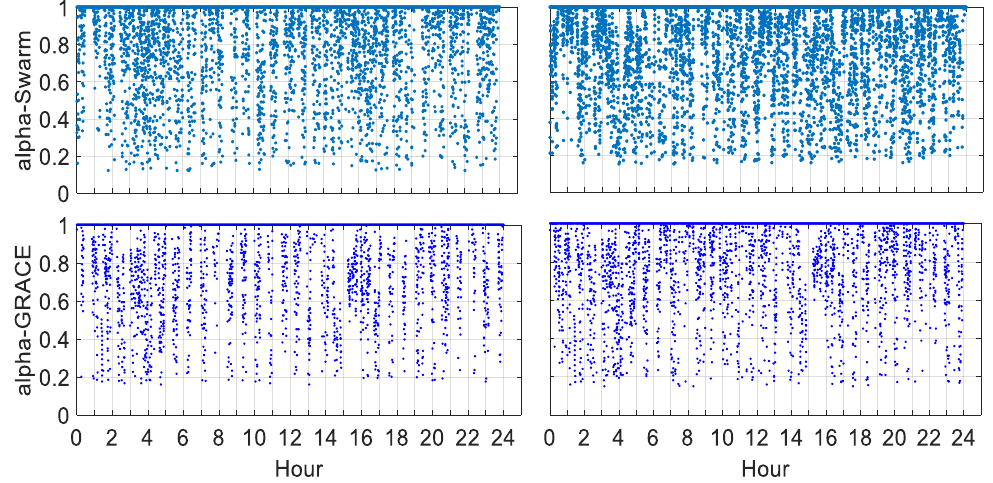
Figure 11. The adaptive factors for Swarm-A and GRACE-A real-time POD solutions from Schemes 3 and 5 on the day of a solar storm. The two upper subplots are for Swarm-A while the two lower subplots are for GRACE-A. The two left subplots are from Scheme 3 (pseudorange-only) and the right are from Scheme 5 (pseudorange and epoch-differenced carrier-phase-based).